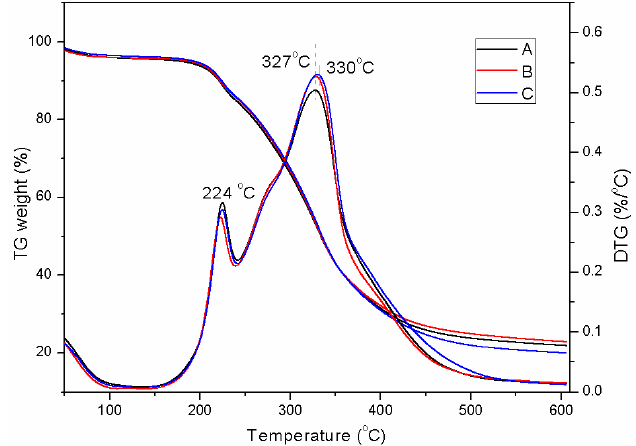
Figure 3. The TG and DTG curves of the adhesive: (A) MSM adhesive, (B) MSM/NCC adhesive, and (C) MSM/MNCC.